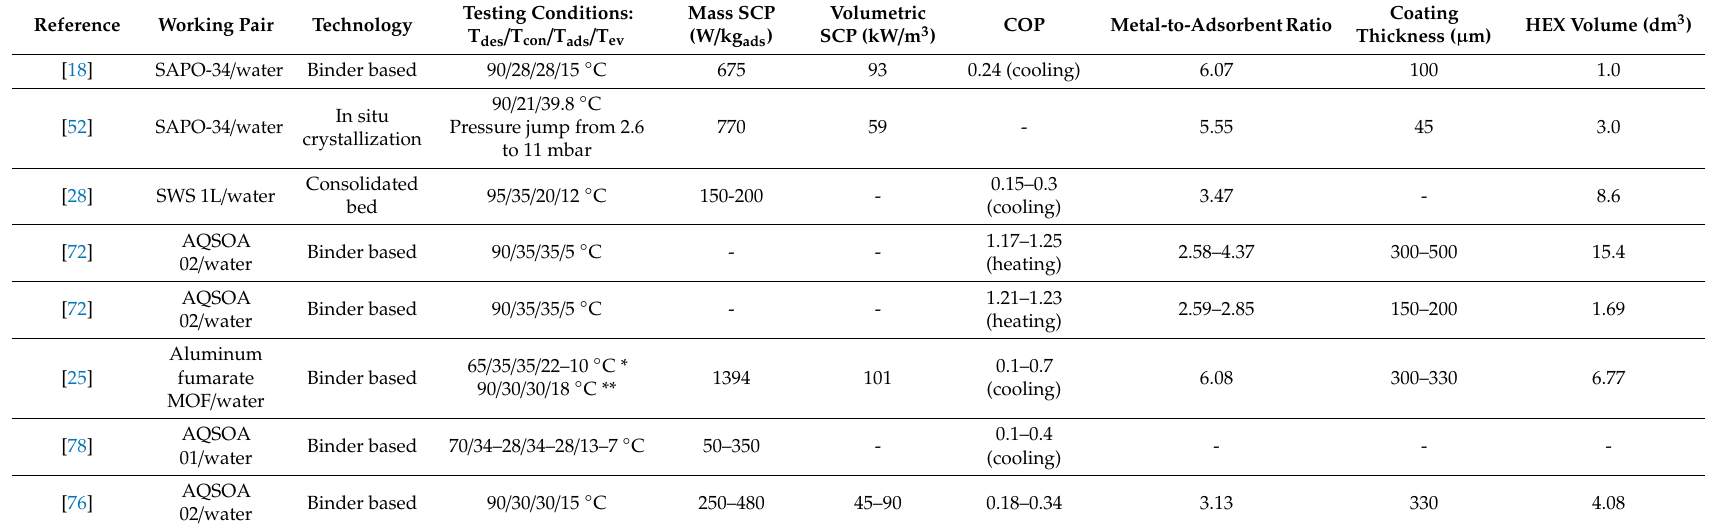
Table 4. Analysis of measured performance over lab-scale coated adsorbers reported in the